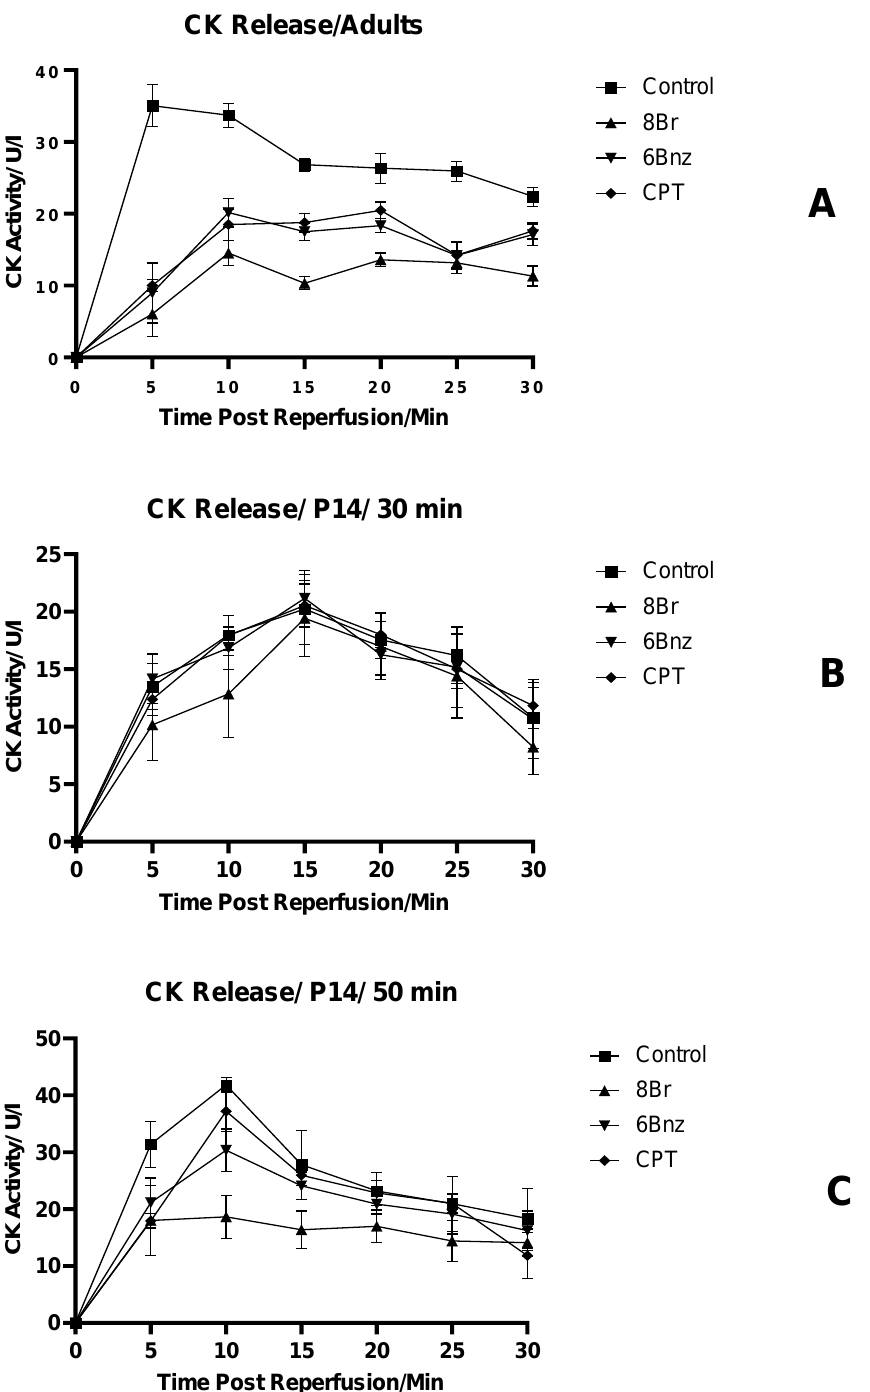
Figure 2. Activity of creatine kinase in coronary effluent during perfusion experiments. ( A ) Adult heart; ( B ) P14 hearts 30 min global ischaemia; ( C ) P14 hearts 50 min global ischaemia. Normalised to coronary flow rate. Error bars represent mean ± SE. n = 6 per group.